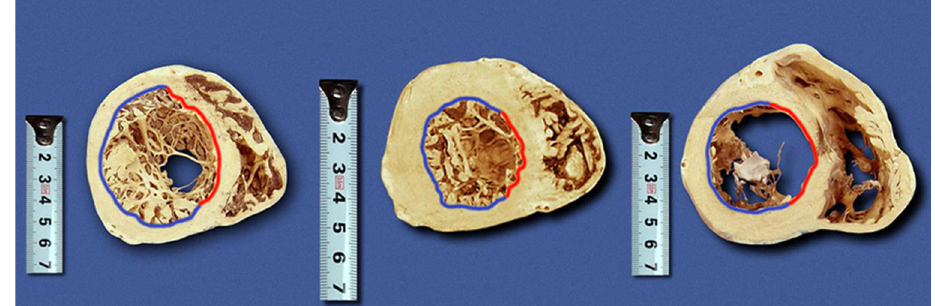
Fig. 2 - From left to right: cranial view, respectively, from equatorial, apical and basal regions of the left ventricle in dilated hearts. The blue line corresponds to the non-septal segment (NSS) and the red line to the septal segment